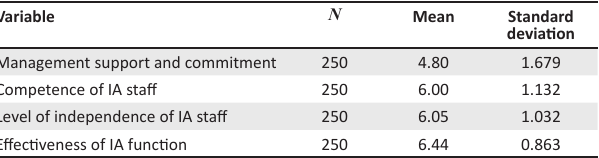
TABLE 3: Descriptive statistics of